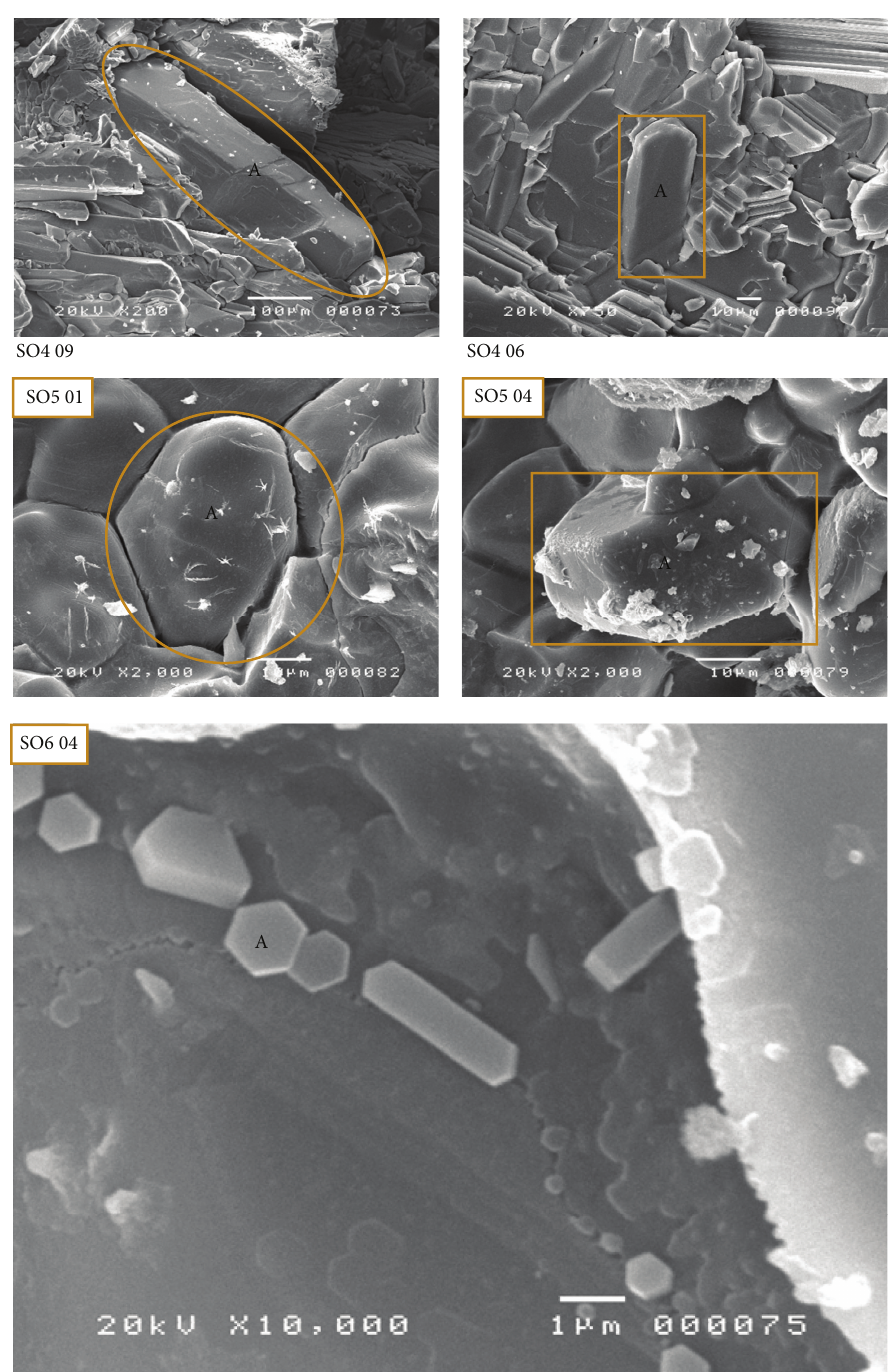
Figure 5: Scanning electron micrograph shows different morphologies of alite mineral (C3S) found in white clinker (A: alite).